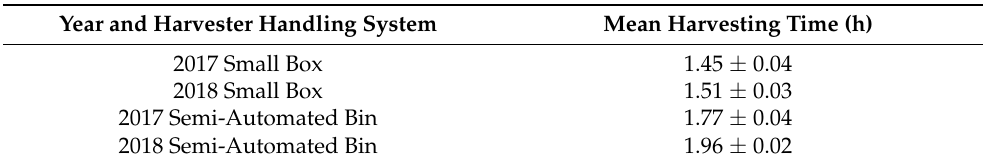
Table 3. Mean harvesting times for a 2.00 h period for both the small box handling system and the semi-automated bin handling system for 2017 and